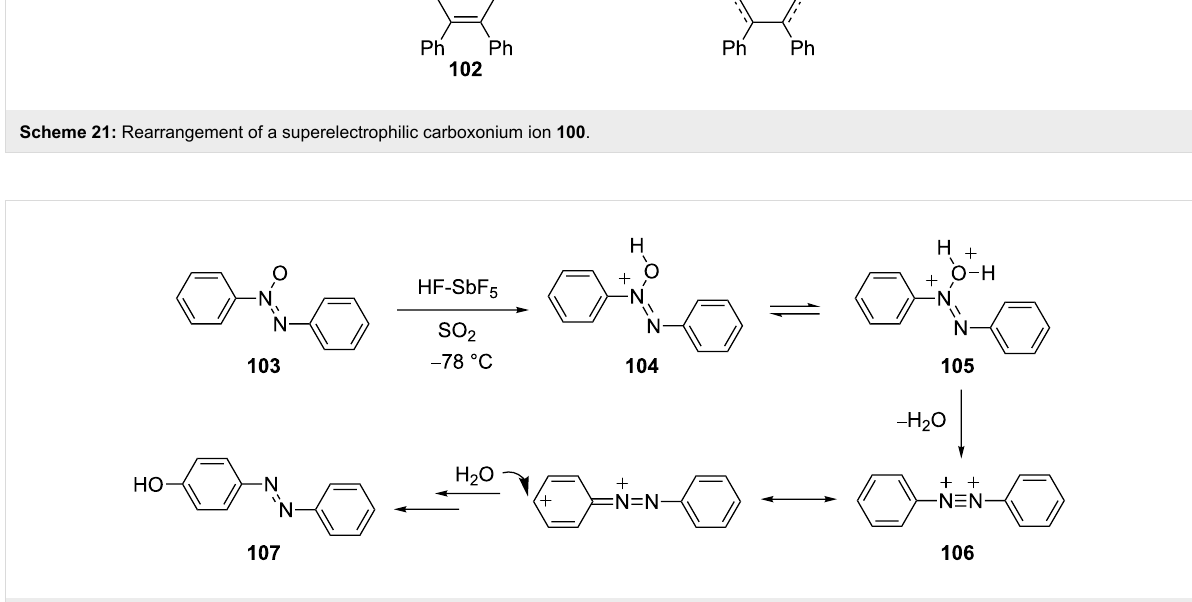
Scheme 22: Proposed mechanism for the Wallach rearrangement.